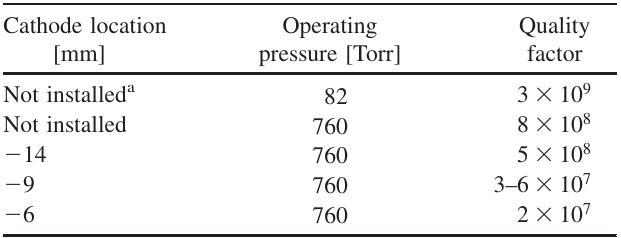
TABLE II. Cavity quality factor.